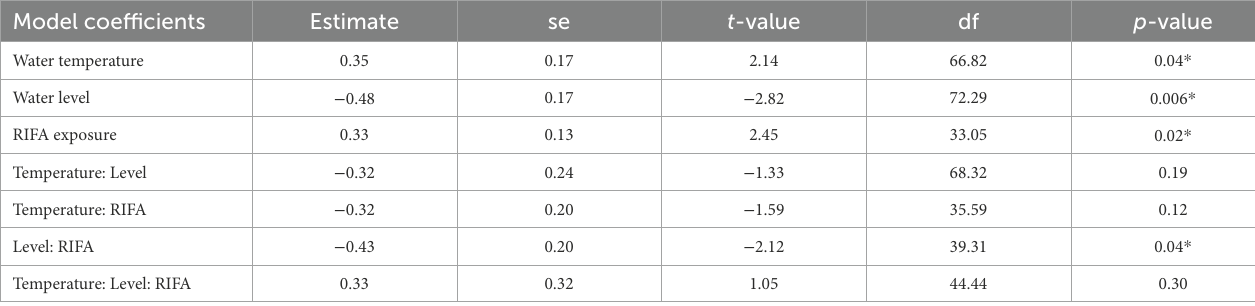
TABLE 5 Results of mixed-effects models for lipid analysis in I. nebulifer toadlets.